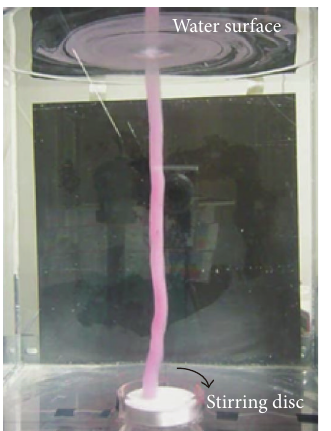
Figure 3: Vortex core in swirling water flow without bubbles ( 𝑄 𝑔 = 0 ).